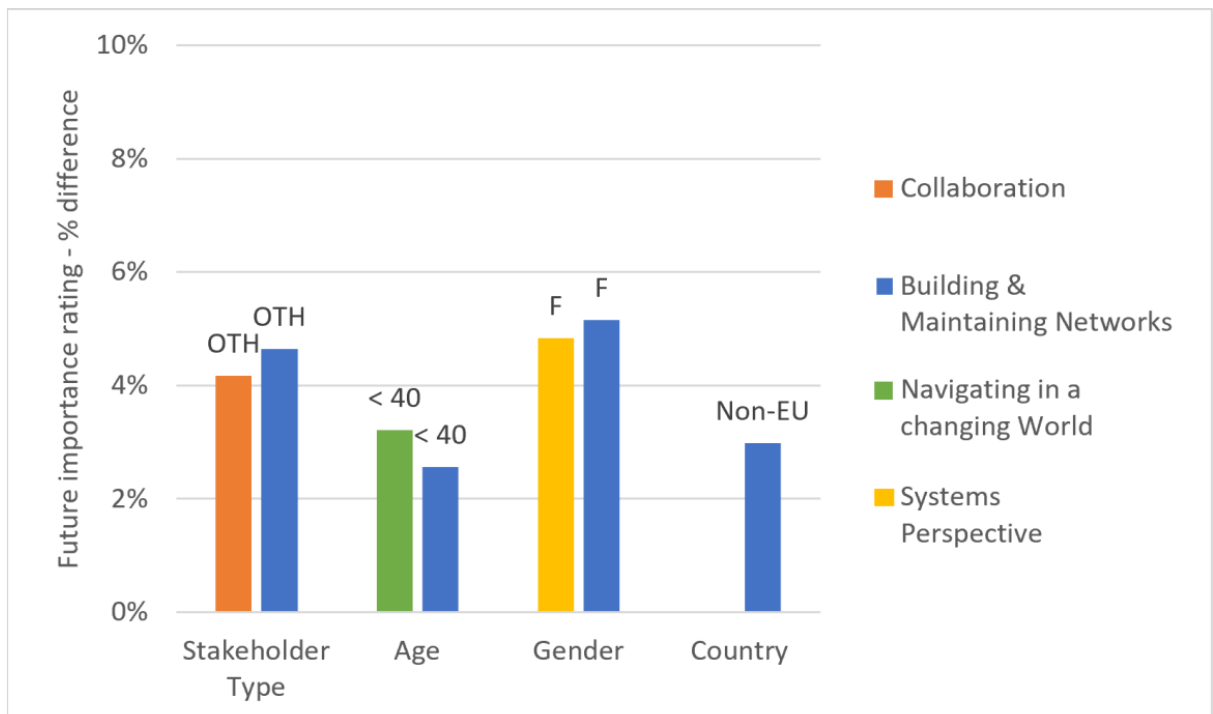
Figure 2. Percentage difference between average ratings of the future importance of skills based on demographic variables. OTH rated “Collaboration” and “Building & Maintaining Networks” higher than FSA ( p < 0.03), under 40 rated “Navigating in a Changing World” and “Building & Maintaining Networks” higher than 40 and over, females rated “Systems Perspective” and “Building & Maintaining Networks” higher than males, and non-EU rated “Building & Maintaining Networks” higher than EU.